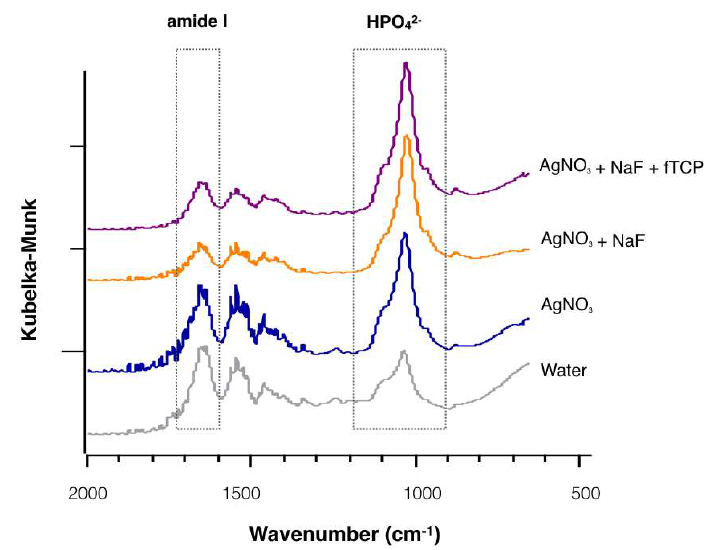
Figure 3. Typical Fourier transform infrared spectra of the artificial dentine caries of the four treatment groups. The peaks corresponding to the wavenumber 1585~1720 cm −1 represent amide I absorbance and the peaks between 900 and 1200 cm −1 represent HPO 42− absorbance.